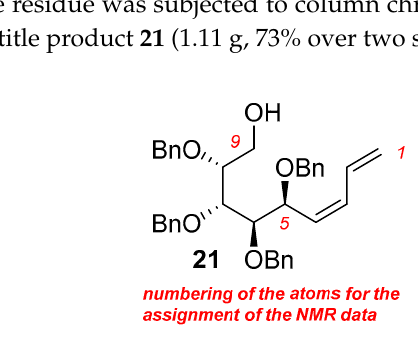
Figure 4. The structure of diene 21 and the numbering of the atoms.